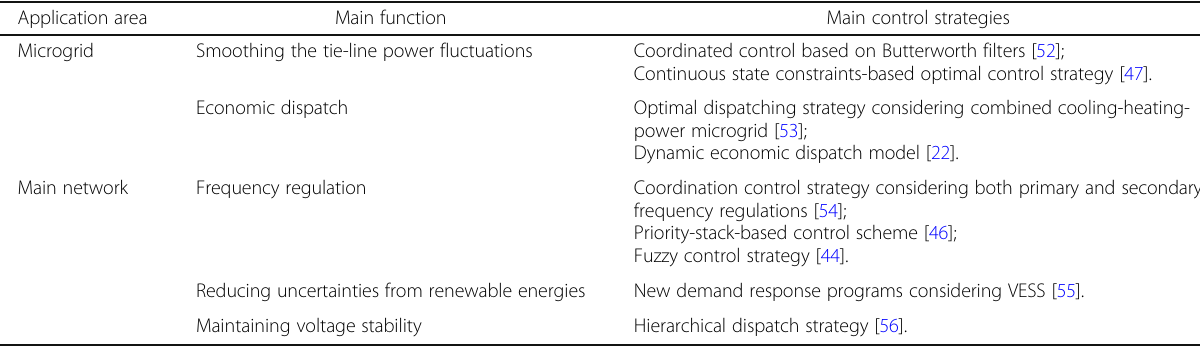
Table 3 The main control strategies of VESS in the previous studies Application